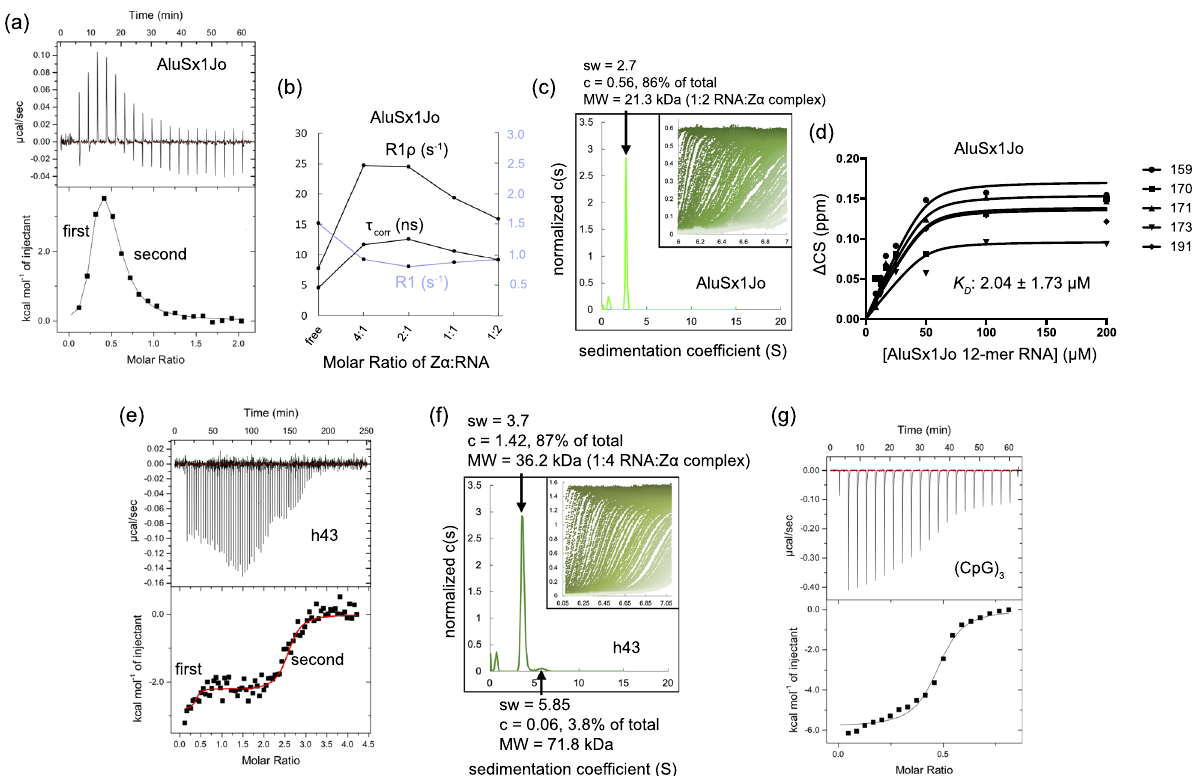
Fig. 5 Z α binds to AluSx1Jo and h43 in the nanomolar to low-micromolar range. a ITC thermogram of AluSx1Jo titrated into Z α and fi t to a two-site binding model. b Average (of the corresponding residue-speci fi c values) longitudinal ( R 1 ), and rotating-frame 15 N NMR relaxation rates ( R 1 ρ ), and the extracted effective overall correlation times ( τ corr ) are plotted versus the molar ratio of Z α :AluSx1Jo in the experiment (residue-speci fi c R 1 , R 1 ρ , and τ corr are shown in Supplementary Fig. 9). Measured values are from one set of relaxation rate experiments. c Sedimentation coef fi cient distribution as obtained from analytical ultracentrifugation (AUC) with a 1:6 molar ratio of AluSz1Jo:Z α . The inset shows the raw data from the AUC run with the window position on the x -axis and absorbance on the y -axis, and individual scans over time going from left to right. d Global K fi t of chemical shift perturbations (CSPs) of binding- d site residues from the 15 N-HSQC titration of AluSx1Jo into Z α , assuming a two-site binding model. Values are determined from one 15 N-HSQC titration. e Isothermal calorimetry (ITC) indicating the multiple Z α domain binding events for E. coli h43. f Sedimentation coef fi cient distribution as obtained from analytical ultracentrifugation (AUC) with a 1:6 molar ratio of h43:Z α . g ITC thermogram and fi t from titrating the (CpG) 3 RNA into Z α . All ITC parameters are given in Table 1. ITC thermograms are representatives of two measurements and AUC data for AluSx1Jo and h43 are determined from one measurement each. Table 1 Parameters extracted from isothermal titration calorimetry